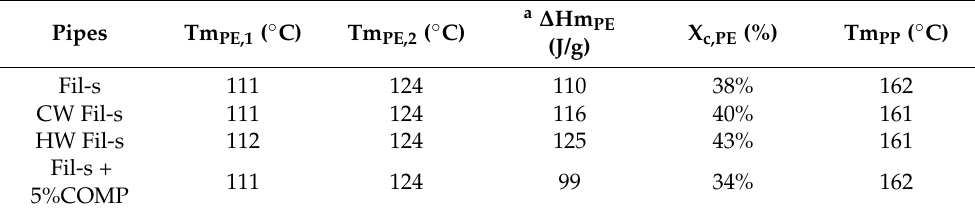
Table 6. Main thermal parameters, measured by second heating scan, for Fil-s based pipes.